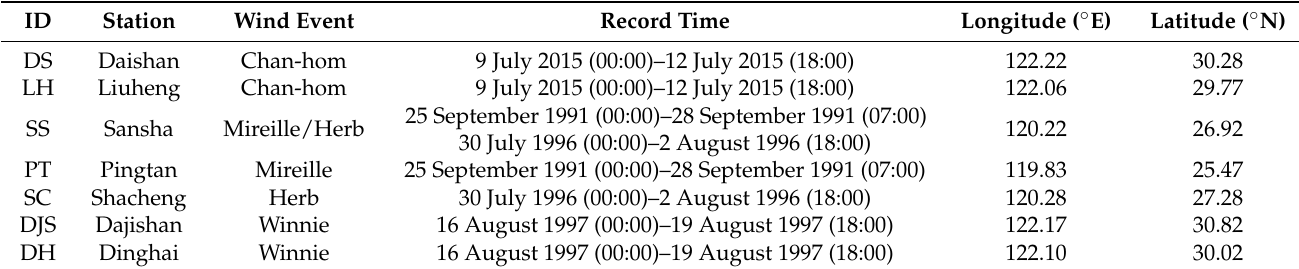
Figure 2. ( a ) Bathymetry of the model and locations of tidal gauge stations (white inverted triangle), ( b ) computational meshes of the study domain. Table 1. Locations, record time at different tidal gauge stations during four typhoon events.